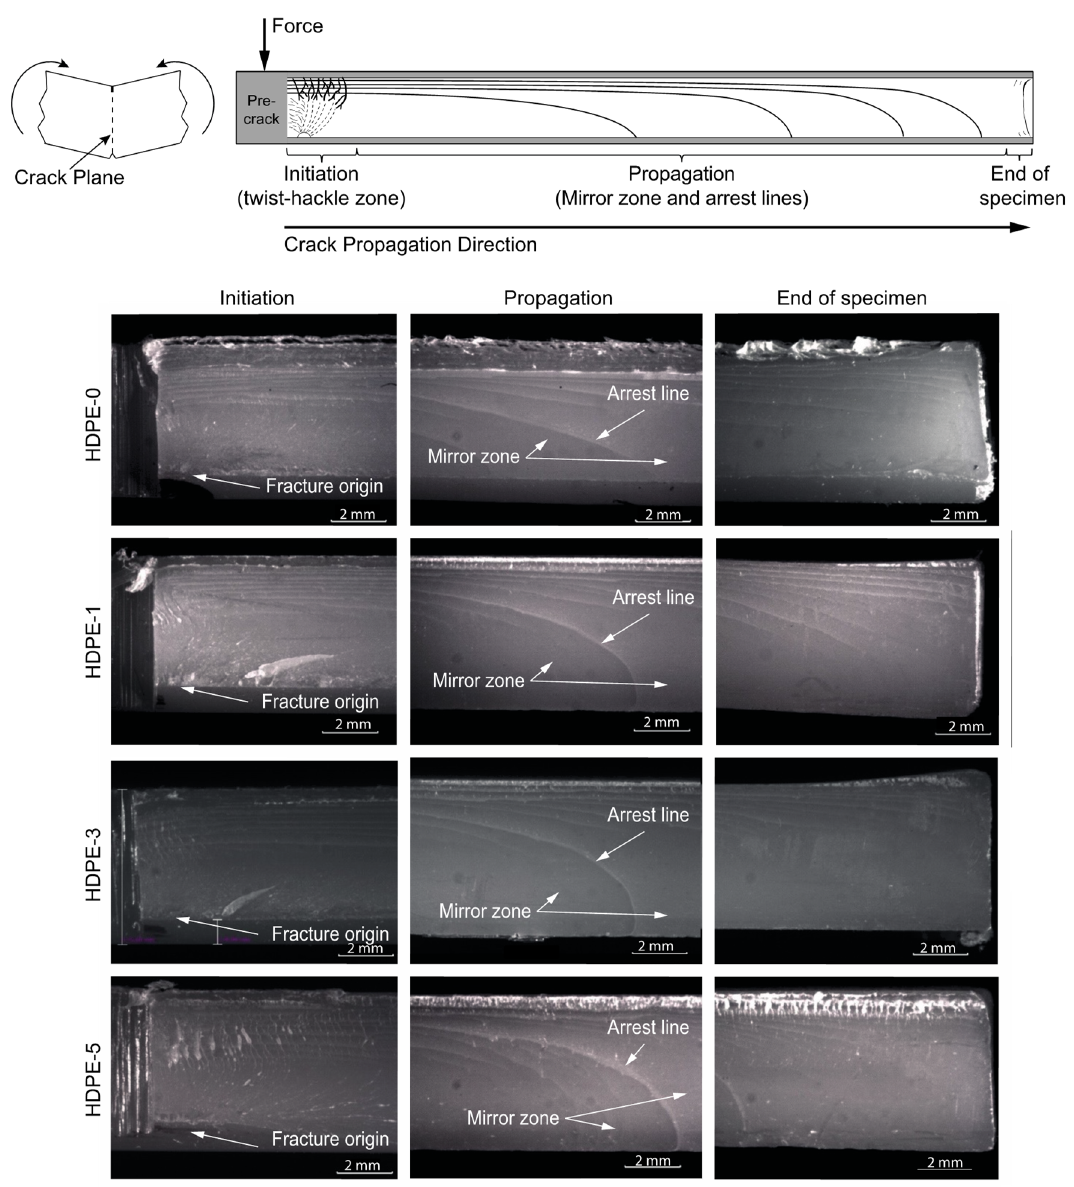
Figure 3. The initiation, propagation, and end-of-specimen fracture zones during RCP in HSDT test specimens for different HDPE–clay nanocomposites (containing 0, 1, 3, and 5 wt% of nanoclay, re- spectively).